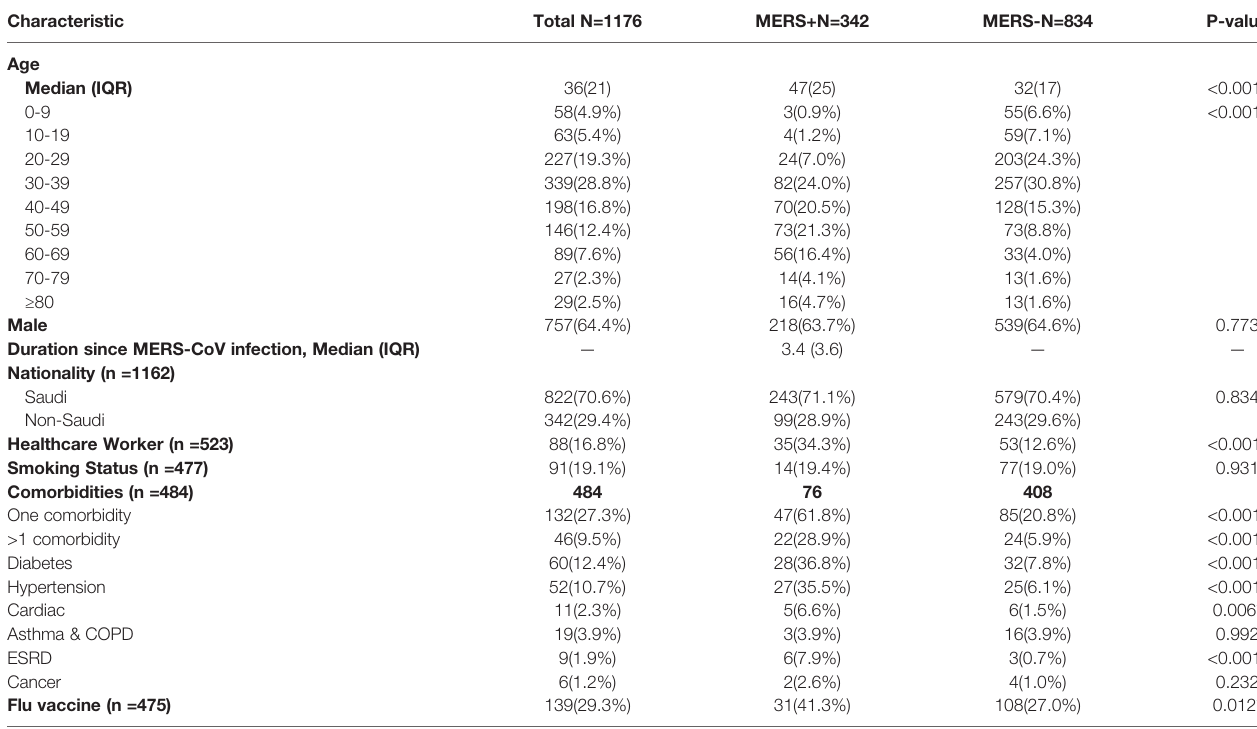
Bold values represent the total number of patients with co-morbidities. *Statistically signi fi cant at p-value